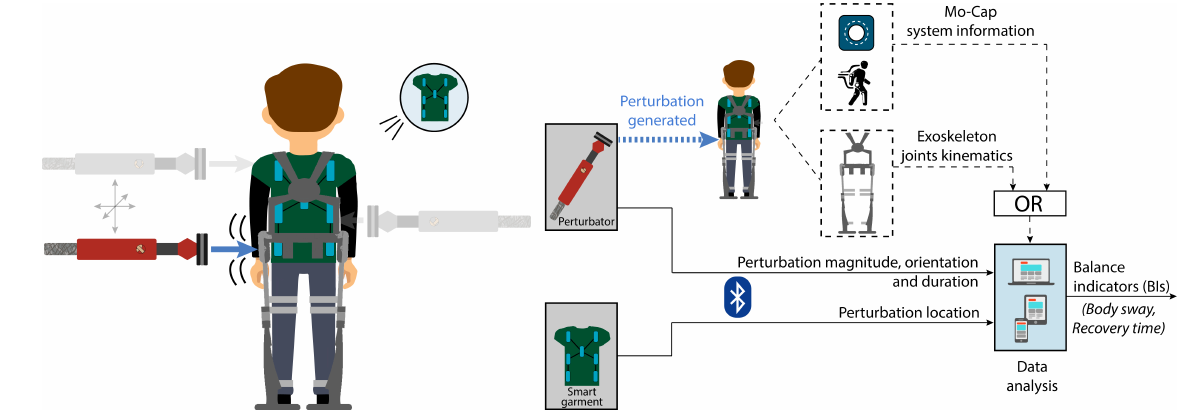
Figure 1. Overview of the BenchBalance testbed. The acquired signals are transmitted via Bluetooth to the processing unit for its